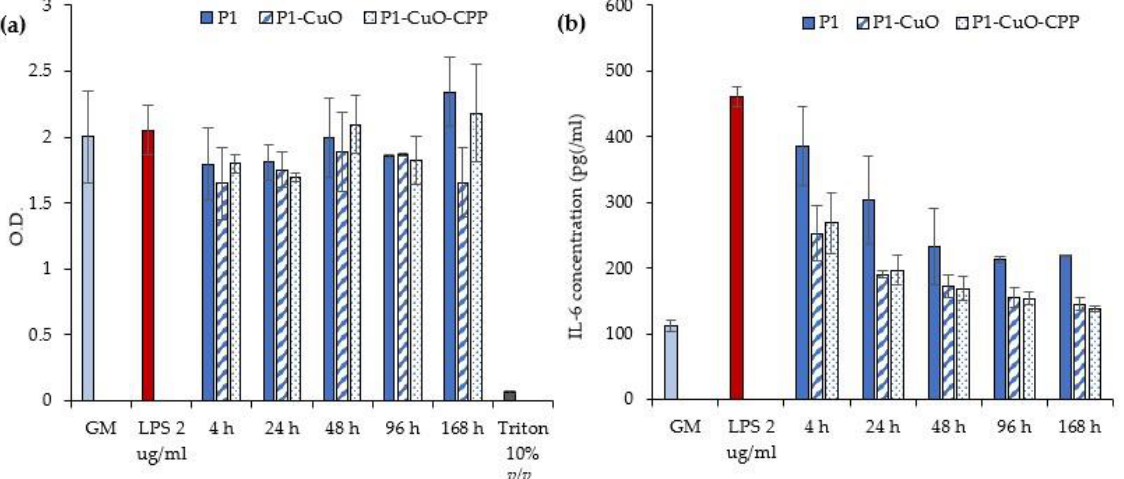
Figure 9. ( a ) Macrophages ’ viability after 24 h of contact with LPS and the scaffolds ’ extracts at different time intervals. ( b ) IL-6 cytokine concentrations (pg/mL) secreted by the macrophages exposed to different time intervals of scaffolds ’ extracts (GM: growth medium; LPS: lipopolysaccharide) (mean values ± SD, n = 5). One-way ANOVA, Scheffé test ( p ≤ 0.05) is reported in the Supplementary Information (SI: Section S1.3.5).